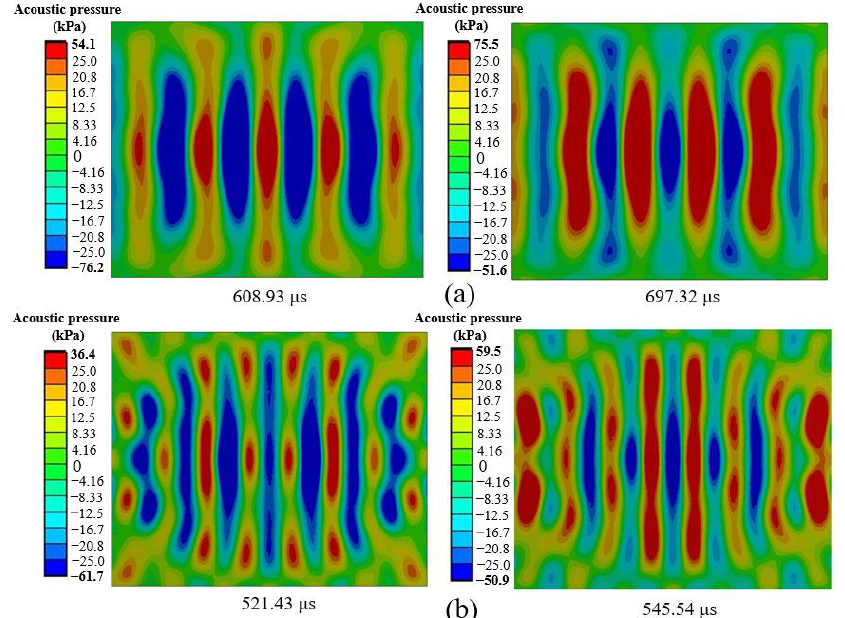
Figure 14. Acoustic pressure distribution in S 2 during the time when the maximum negative (left) and positive (right) values occurred for ( a ) model A and ( b ) model B.